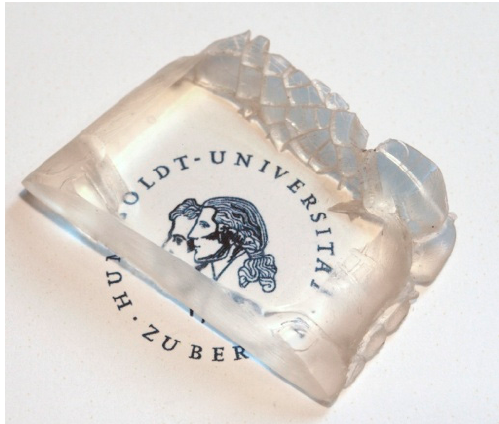
Figure 19. Photograph of a representative composite sample with MgF 2 (10 wt %) in PolyHEMA. Reproduced from Reference [62] with the permission of the Royal Chemical Society.